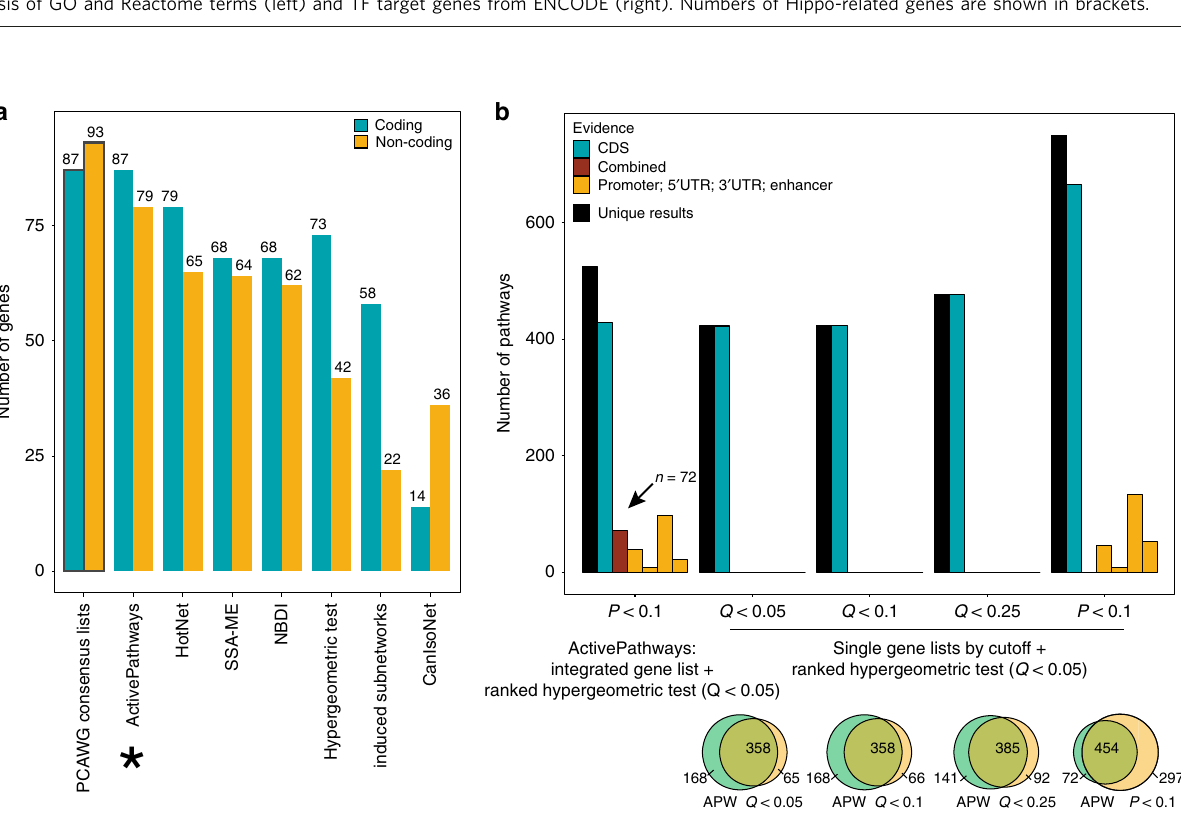
Fig. 5 Benchmarking of ActivePathways. a Comparison of ActivePathways with six additional pathway and network analysis methods used in the PCAWG pathway and network consensus analysis. ActivePathways best recovers the consensus lists of pathway-implicated driver genes with coding and non- coding mutations (indicated by asterisk). The consensus lists are shown in the leftmost bars of the plot and have been compiled through a majority vote of the seven methods in the PCAWG pathway and network analysis working group. b Comparison of ActivePathways (leftmost bars) and common pathway enrichment analysis using multiple signi fi cance cut-offs of PCAWG gene lists with protein-coding and non-coding mutations. ActivePathways shows increased sensitivity of pathway analysis even at the most lenient gene list signi fi cance cut-offs and recovers additional pathways only detected through integration of multiple datasets (dark